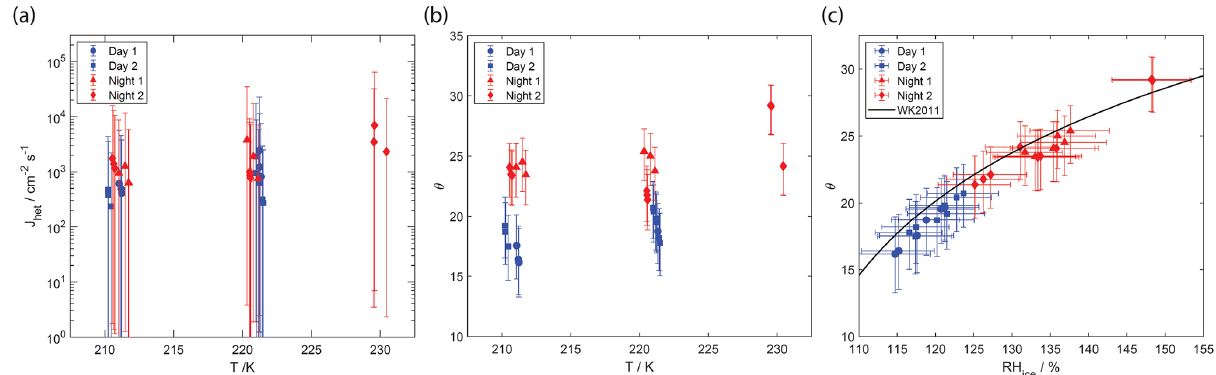
Figure 8. Deposition ice nucleation (DIN) data of examined ACE-ENA particle samples (solid symbols). (a) Heterogeneous ice nucleation rate coefficients ( J het ) as a function of temperature. (b) Contact angles ( θ ) corresponding to J het values shown in (a) . (c) θ values for relative humidity with respect to ice (RH ice ) under which DIN was observed. Solid line represents the DIN parameterization by Wang and Knopf (2011).